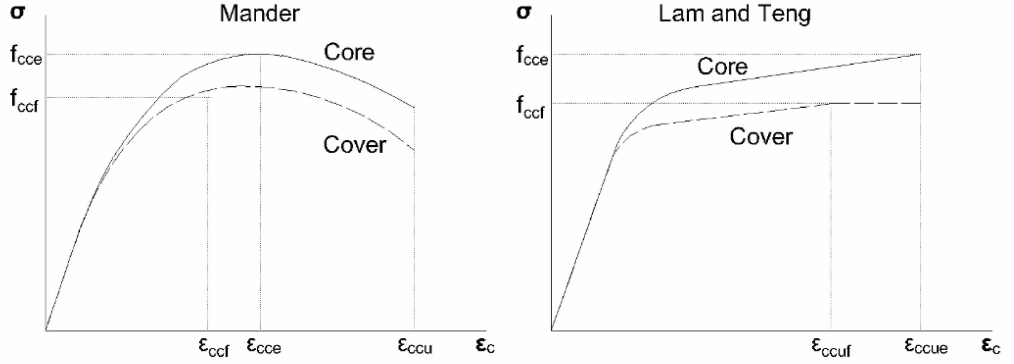
Figure 6. Confinement models for core and